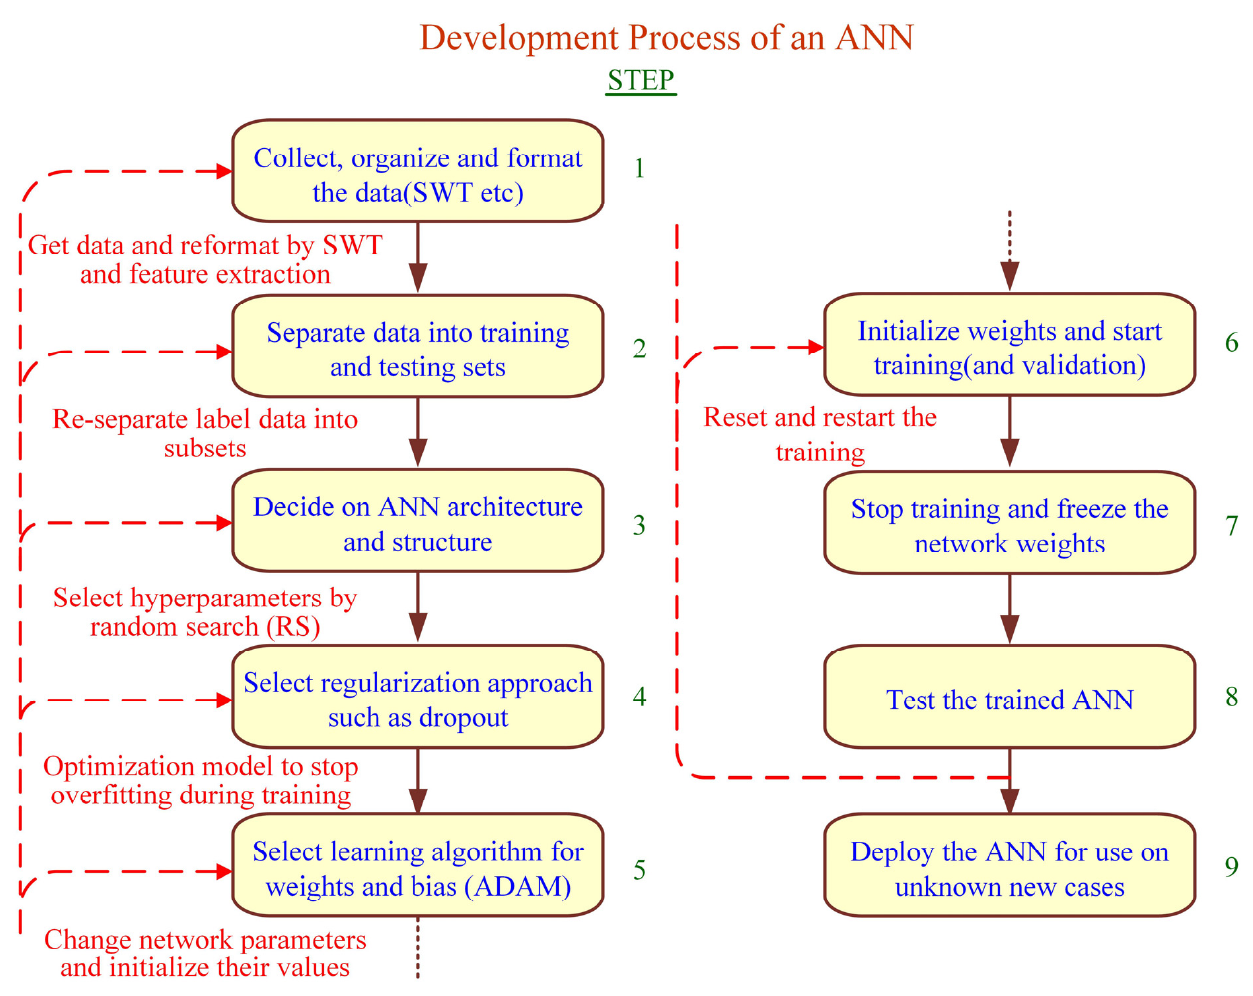
Figure 8. The overall development of ANN and its optimization.